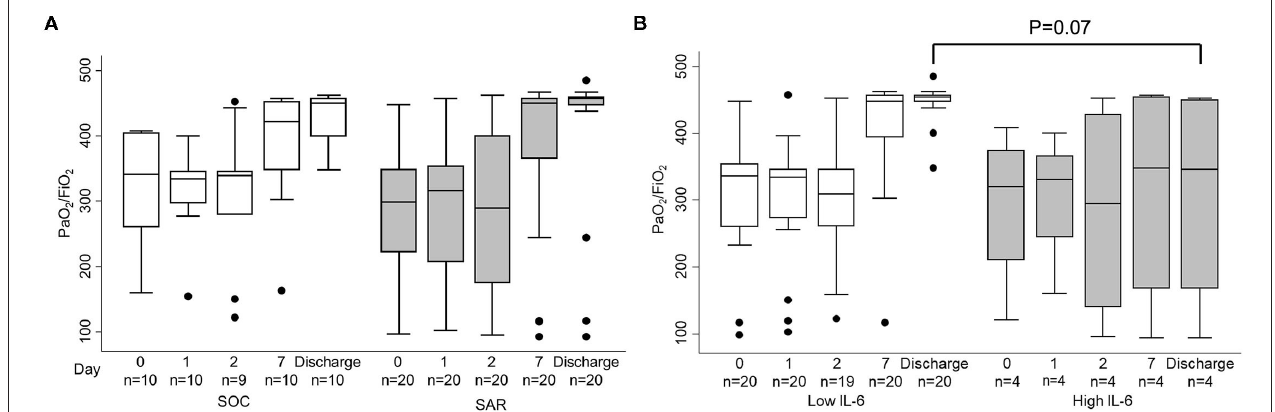
FIGURE 3 | Evolution of partial pressure of arterial oxygen/fraction of inspired oxygen (PaO2/FiO2) throughout study visits. Patients are grouped depending on (A) allocated interventions: standard care (SC) or sarilumab (SAR) and (B) level of serum interleukin-6 (IL-6) at randomization (cut-off for high levels ≥ 30 pg/ml). Two patients died and their last observed value was carried forward. IL-6 levels at randomization were available only in 24 patients; high IL-6 levels were observed in 3 patients from the SAR group and 1 patient from the SC group. Data are shown as interquartile ranges (p75 upper edge of the box, p25 lower edge, p50 midline) as well as the p95 (line above box) and p5 (line below). Dots represent outliers. Statistical significance was determined with the Mann–Whitney U test.